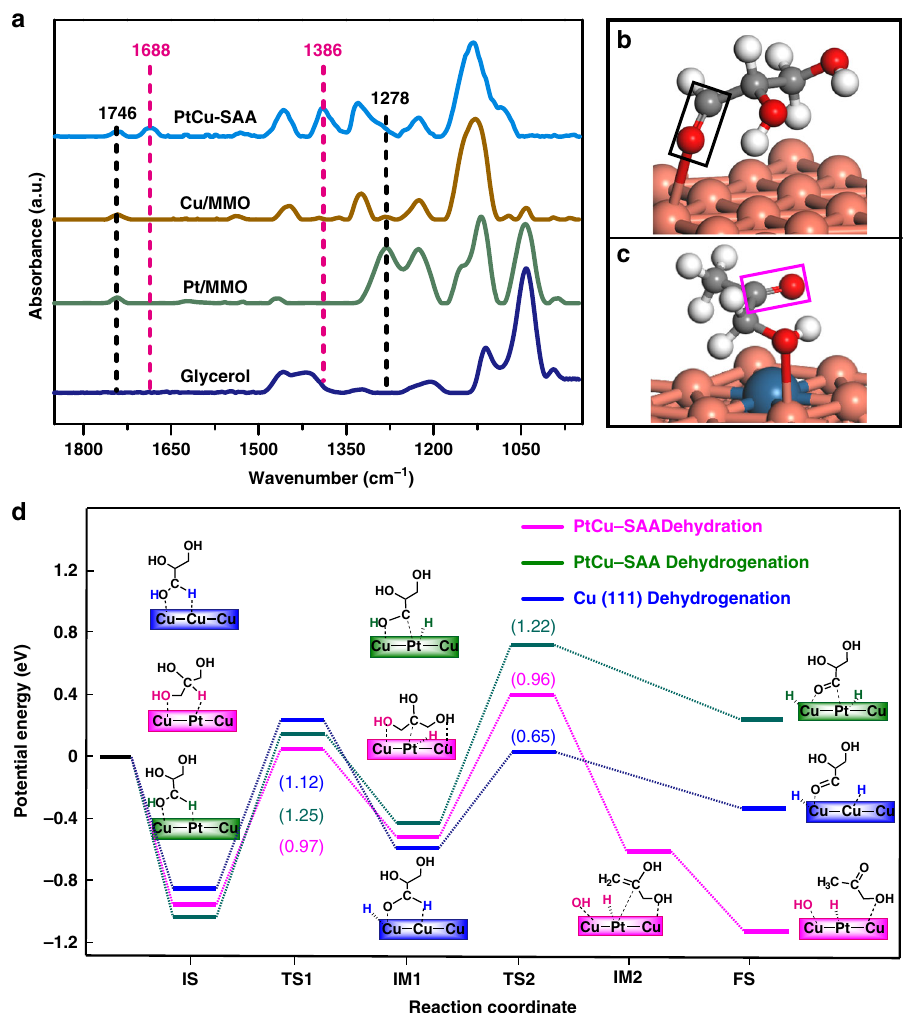
Fig. 8 Reaction pathway based on in situ experiments and DFT calculations. a In situ DRIFTS spectra of gaseous glycerol and the chemically adsorbed glycerol over Pt/MMO, Cu/MMO, and PtCu – SAA, respectively. The corresponding geometric structures for the consequent products of glycerol dissociation on b Cu (111) surface, and c PtCu – SAA (111) surface. Cu, orange, Pt, blue, C, grey, O, red, H, white. d Potential energy pro fi les for glycerol hydrogenolysis on Cu (111) and PtCu – SAA (111) surface. The magenta line and green line illustrates dehydration and dehydrogenation step on PtCu – SAA surface, respectively, and the blue line displays dehydrogenation step on monometallic Cu (111) surface. Numbers in the parentheses represent reaction barriers of elementary